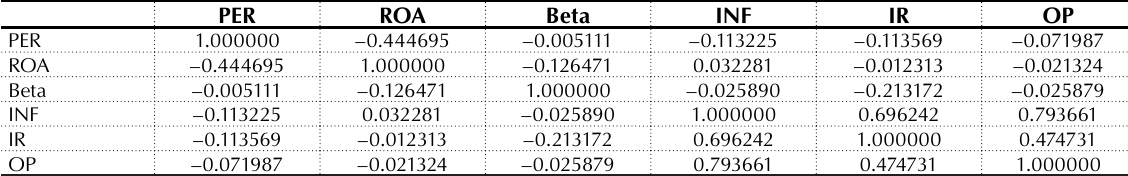
Table 2. Coefficient correlation